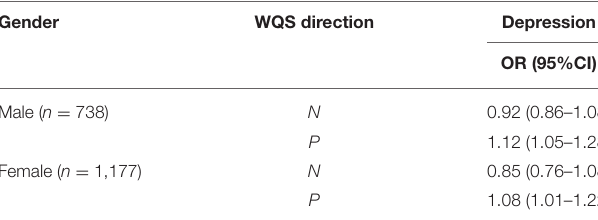
TABLE 6 | Associations of WQS index with depression in both